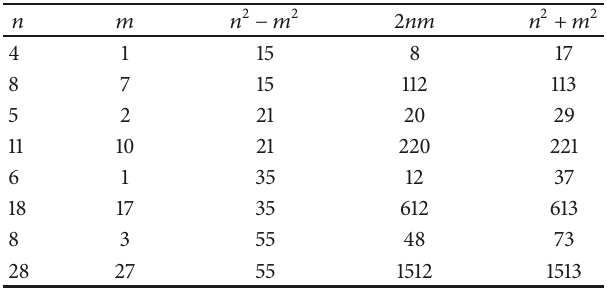
Table 2: Pairs of primitive Pythagorean triples with identical leg,